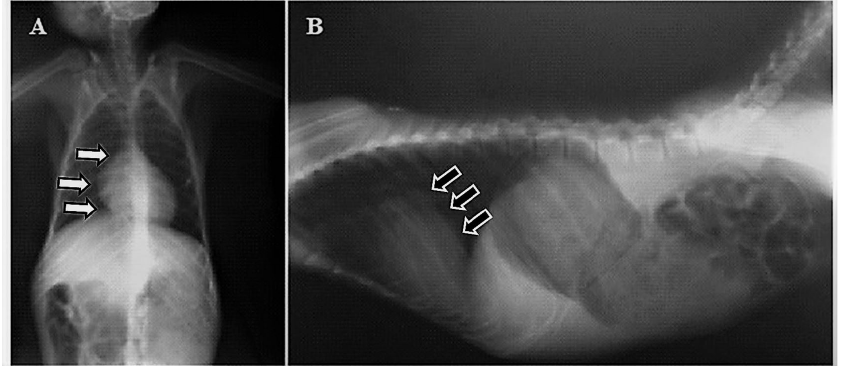
Figure 4. (A) Radiographic image in ventro-dorsal position, evidencing remission of cardiomegaly during the treatment (filled arrows); (B) Radiographic image in a right lateral position, evidencing remission of remodeling of the cardiac silhouette (arrow